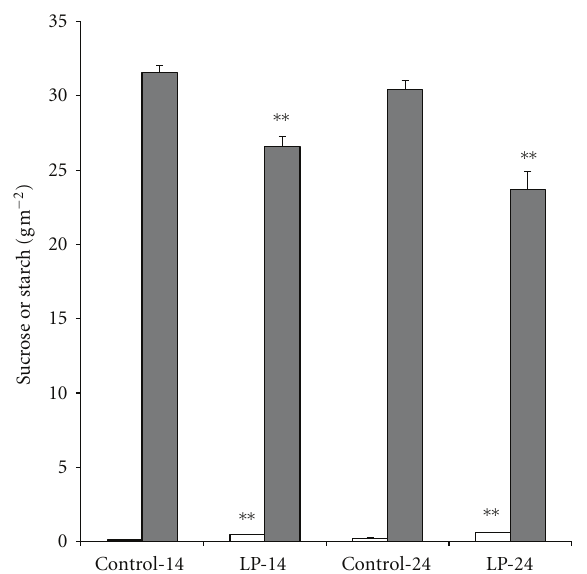
Figure 6: Leaf sucrose and starch contents in soybean plants grown with original pots (Control) and with larger pots (LP). Summary of growth conditions is described in Figure 1. Open bar, sucrose; closed bar, starch. Vertical bars, S.D. ( n = 3). ∗∗ P < 0 . 01 ( t -test) when compared with control.